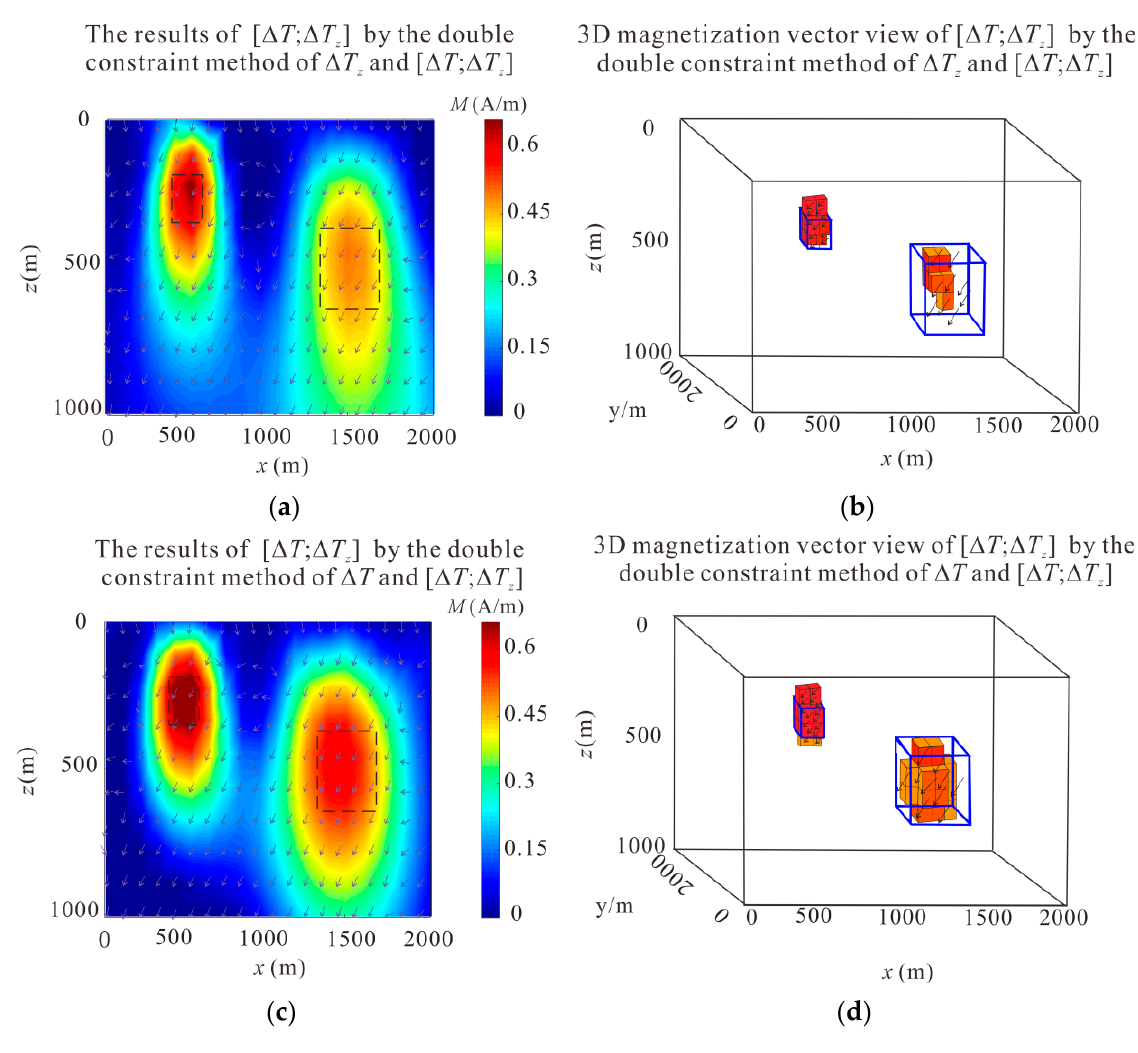
Figure 3. Models with different depths obtained by the double constraints inversion method of CMG data and different component airborne magnetic data. ( a , b ) The results of CMG data with Equation (10) and the corresponding 3D magnetization vector view with a cutoff value of 0.471 A/m, with slices corresponding to y = 1000 m; and ( c , d ) the results of CMG data with Equation (8) and the corresponding 3D magnetization vector view with a cutoff value of 0.471 A/m, with slices corresponding to y = 1000 m.